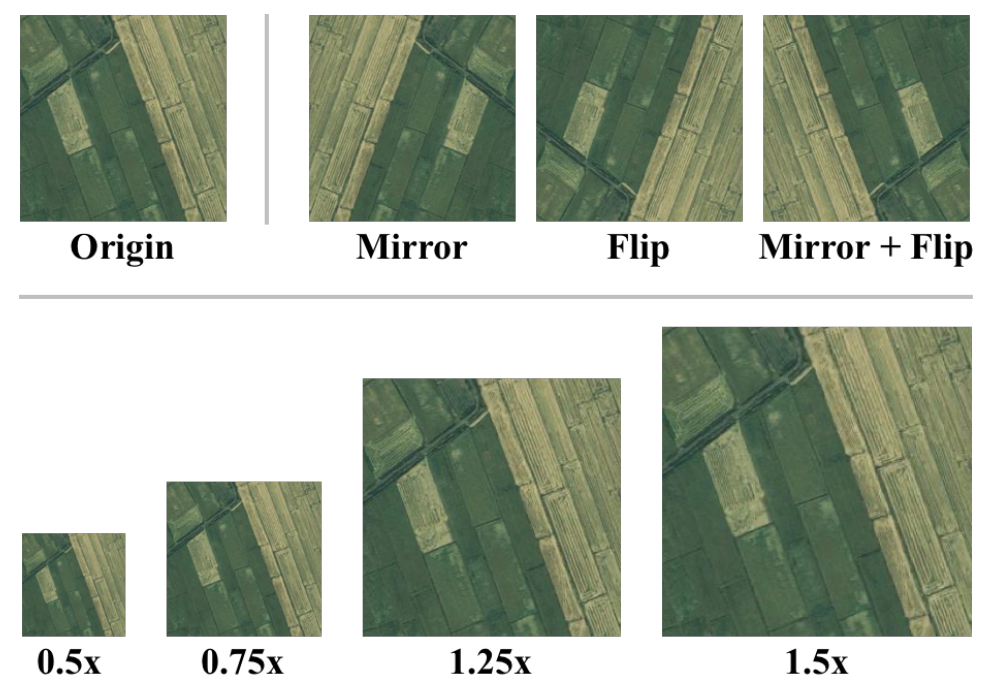
Figure 1. Examples of basic image preprocessing